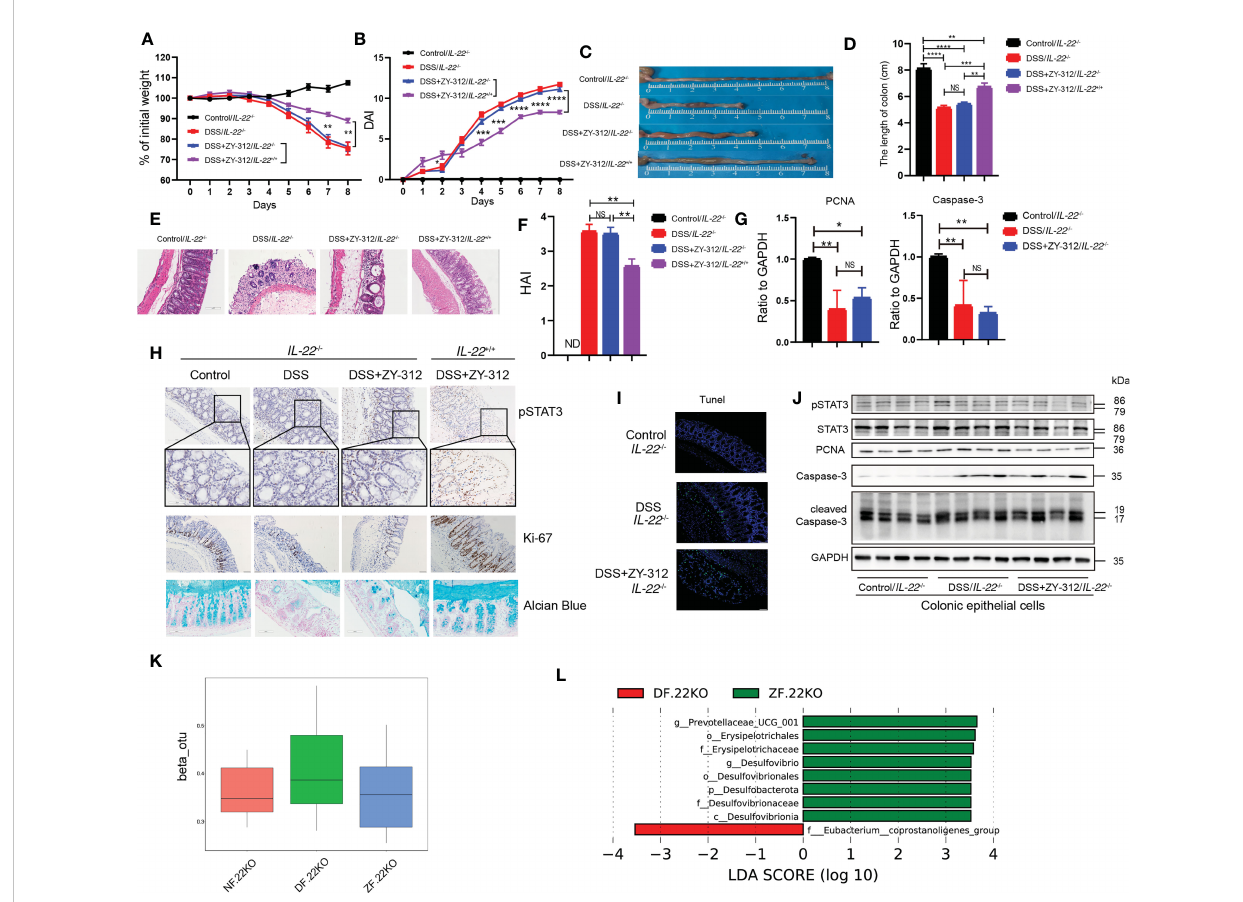
FIGURE 5 B. fragilis up-regulated IL-22/pSTAT3 pathway to facilitate colonic enterocytes proliferation and mucus secretion, inhibit apoptosis, and impact gut microbiota. (A, B) Percent of weight loss (A) and DAI (B) were monitored daily starting from DSS administration. Control/ IL-22 -/- group (N=4), DSS/ IL-22 -/- group (N=7), DSS+ZY-312/ IL-22 -/- group (N=8), DSS+ZY-312/ IL-22 +/+ group (N=7). N, number of mice. (C) Representative colon morphology. (D) Statistical analysis of colon length. (E) H&E staining of colon tissues (Scale bars, 200 m m). (F) Statistical analysis of HAI. (G) qPCR analysis of Caspase-3 and PCNA in colon tissue. (H) Immunochemistry analysis of pSTAT3 and Ki-67, alcian blue analysis of mucus from IL-22 +/+ and IL-22 -/- mice (Scale bars, 200 m m). (I) Tunel assay analysis of colon tissue from IL-22 -/- mice (Scale bars, 200 m m). (J) Western Blot analysis of pSTAT3, STAT3, PCNA, cleaved Caspase-3, and Caspase-3 from colonic epithelial cells in IL-22 -/- mice. (K) The b diversity analysis of microbiota in Stat3 △ IEC mice between groups. (L) LEfSe analysis of differential bacteria in feces between the DSS group and ZY-312 group with different levels meeting a signi fi cant LDA threshold value of >3.5 in IL-22 -/- mice. NF.22KO indicates Control/IL-22 -/- group. DF.22KO indicates DSS/IL-22 -/- group. ZF.22KO indicates DSS+ZY-312/IL-22 -/- group. Data are presented as Mean ± SEM (A, B, D, F, G) . The P value was calculated using two-way ANOVA (A, B) . Statistical analysis was performed using one-way ANOVA (D, F, G) . * p < 0.05,** p < 0.01, *** p < 0.005, **** p < 0.001. ND indicates undetectable. NS indicates no signi fi